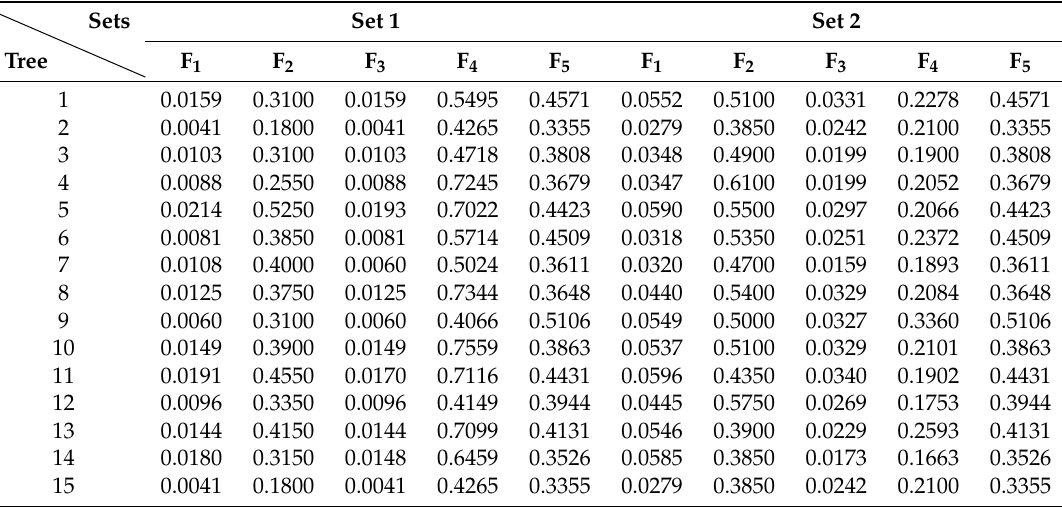
Table 3. Example of 15 trees for modelling.